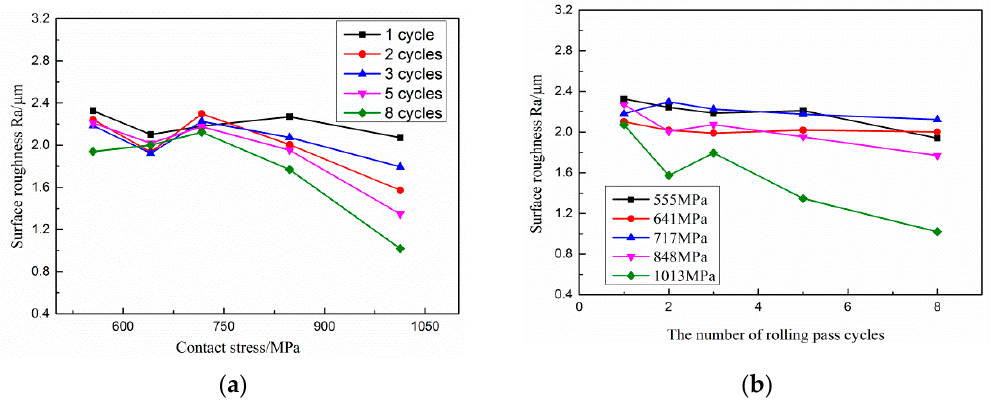
Figure 9. Influence of rolling parameters on rolled surface roughness: ( a ) The variation of the surface roughness with contact stress; ( b ) The variation of the surface roughness with the number of rolling pass cycles.